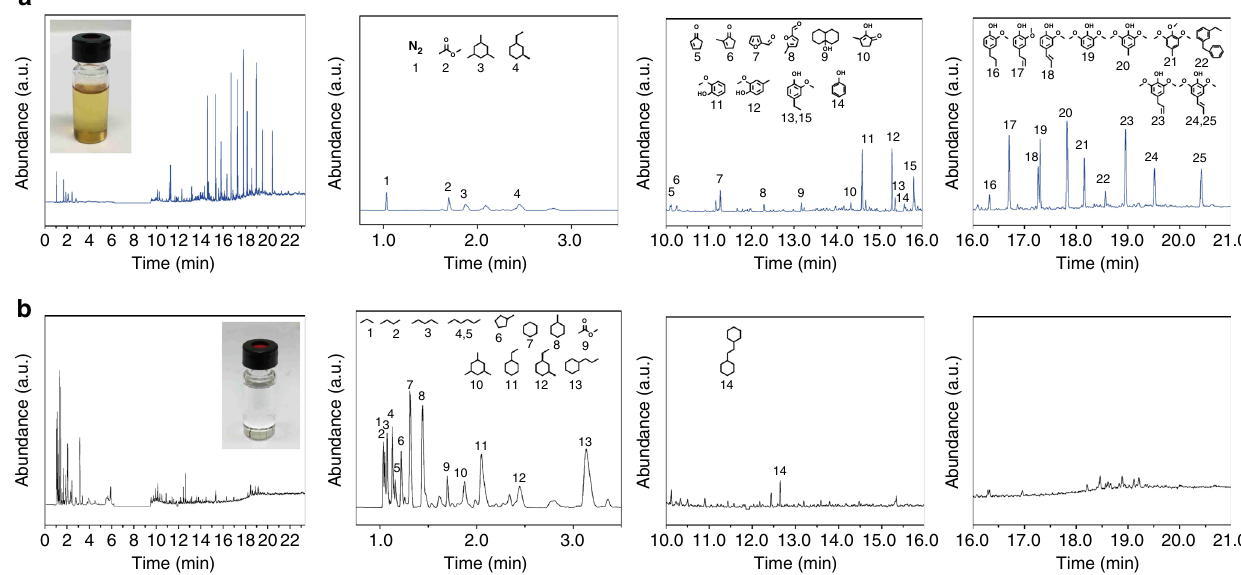
Fig. 5 GC-MS analysis before and after upgrading. a GC-MS analysis of WIBO dissolved in decalin before upgrading. b GC-MS analysis of upgrading product after a batch reaction. Reaction conditions: WIBO (86.2 mg), Pd/m – MoO 3 – P 2 O 5 /SiO 2 (170.8 mg), decalin (7 mL), 453 K, 1 MPa H 2 , 4 h, stirred at 800 rpm. MS detector was off from 6.2 to 9.5 min, and 11.8 to 11.9 min to block decalin and tetralin signals. The overall GC-MS patterns and three enlarged regions are shown. Insets show the images of mixtures before and after upgrading, respectively consistent with the correlation between the Brønsted acid sites increasing the number of exposed surface atoms by using very and the dehydration activity 16, 23 . It is also observed that Pd/ low Pd loading amount of 0.48 wt%. The catalysts with different P 2 O 5 /SiO 2 has lower dehydration activity compared with Pd/ Brønsted acid sites (Supplementary Table 5) were compared in MoO 3 /SiO 2 (12.8 vs. 19.8%), although its Brønsted acid sites is the dehydration of cyclohexanol (Supplementary Table 6), which higher. This could be due to its relatively weaker Brønsted acid is the most important intermediate in the HDO of phenol. Since strength 13 . The role of Lewis acid site on phenol conversion was most of the samples show comparable Brønsted acid strength, further studied by performing diffuse-re fl ectance infrared Fourier respectively, revealed by resonance position of 31 P MAS NMR spectrum (except Pd/P 2 O 5 /SiO 2 (P:Mo = 1:0) which shows transform spectroscopy (DRIFTS) upon exposure of the oxidized weaker Brønsted acid strength), one can look into the correlation and reduced catalyst (Pd/m – MoO 3 – P 2 O 5 /SiO 2 ) to a phenol/He mixture at reaction temperature (383 K). In the measurements, between Brønsted acid and dehydration activity. The result shows the reduced catalyst was fi rst treated with 5% H 2 /Ar at 383 K that only samples containing Brønsted acid sites have activity, before exposed to phenol/He mixture. The DRIFTS spectra of suggesting the dehydration is a Brønsted acid-catalyzed process. both reduced catalyst and oxidized catalyst (Fig. 4b) show bands Speci fi cally, Pd/m – MoO 3 – P 2 O 5 /SiO 2 (P:Mo = 1:1, the reduced – 1 catalyst shown in the main work) with the most Brønsted acid , which correspond to at 1597, 1497, 1475, 1352 and 1267 cm sites is a more active dehydration catalyst, and also Pd/ different vibrational modes of phenoxy species 33 . Compared with oxidized catalyst, the reduced catalyst shows more pronounced m – MoO 3 – P 2 O 5 /SiO 2 (P:Mo = 2:1) with higher Brønsted acid bands at 1684, 2951 and 2874 cm – 1 (Fig. 4b, Supplementary sites compared with Pd/MoO 3 /SiO 2 (P:Mo = 0:1) has higher dehydration activity (conversion: 25.2 vs. 19.8%), which are Fig. 26), which could be assigned to the v (C = O) and v (C – H) NATURE COMMUNICATIONS | 8: 591 | DOI: 10.1038/s41467-017-00596-3 |